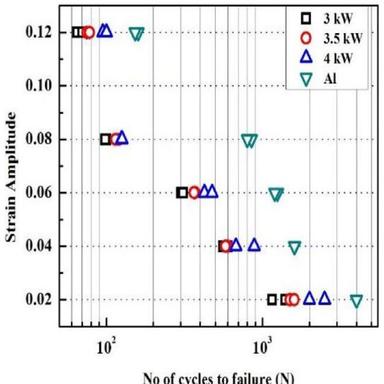
Variations in "Strain amplitude" with "Number of cycles" obtained from the low cycle fatigue tests of the laser brazed joints.